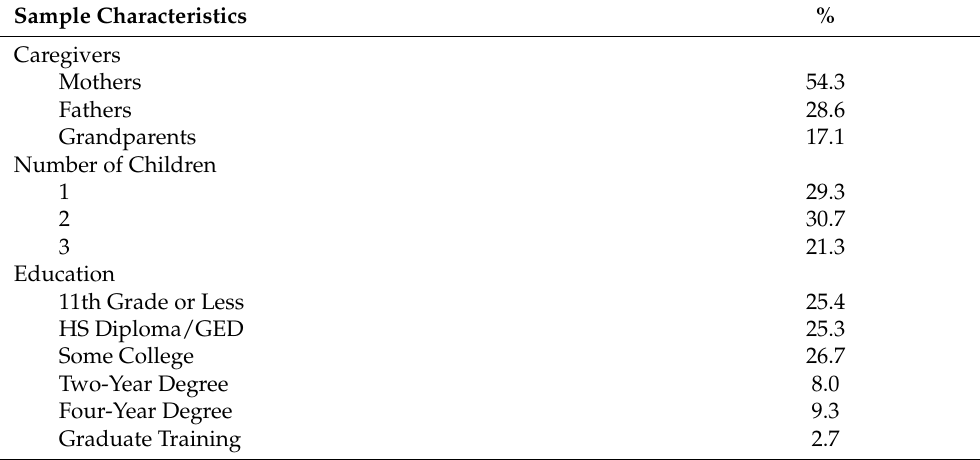
Table 1. Participant Demographics (N = 70). Sample